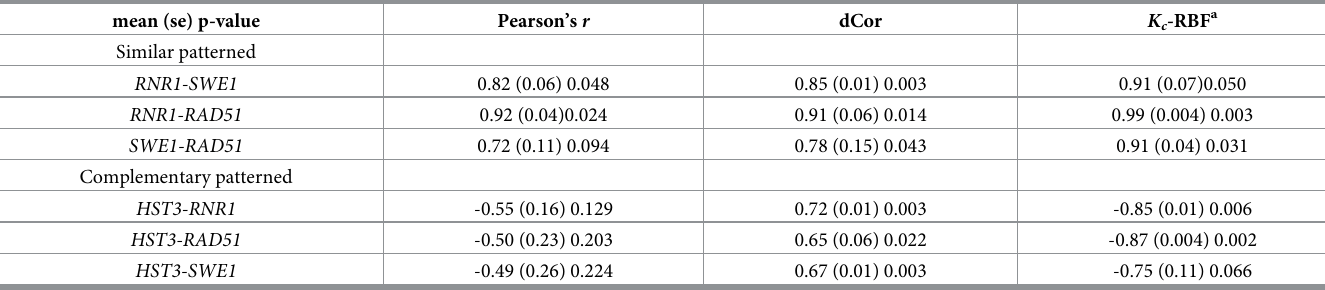
Table 5. Pearson’s r , dCor, and K c -RBF estimated for the pairs of similar and complementary patterned cell cycle genes in yeast. mean (se) p-value Pearson’s r dCor K c -RBF a